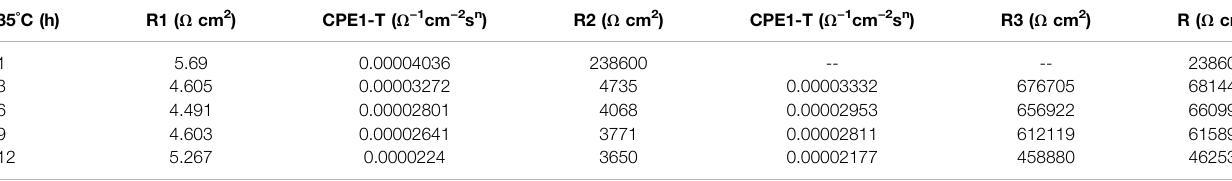
TABLE 10 | Impedance fi tting data of weld zone soaked in arti fi cial seawater at 35 ° C for 12 h 35 ° C (h)